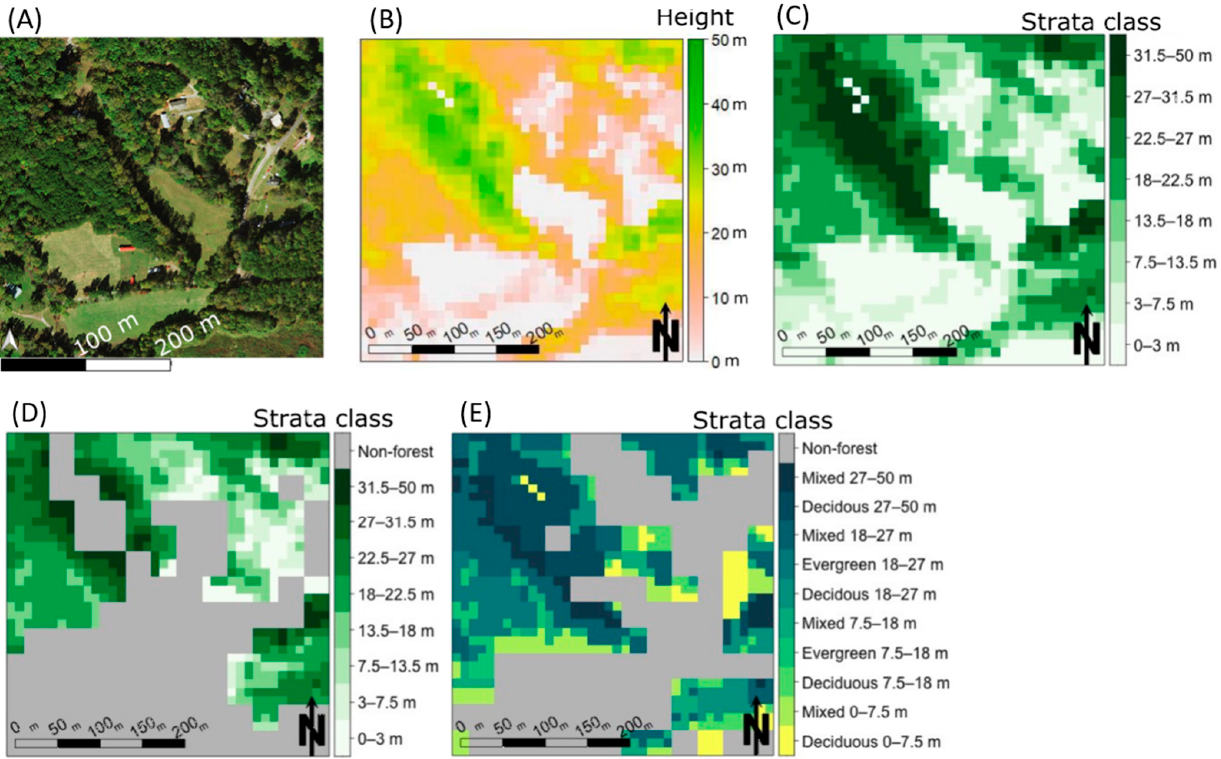
Figure 7. Comparison between 1 m NAIP natural color composite (left), 10 m NAIP DHM (center), and 2 m NAIP DHM (right) for softwood ( A ) and hardwood ( B ) areas in the state of TN.